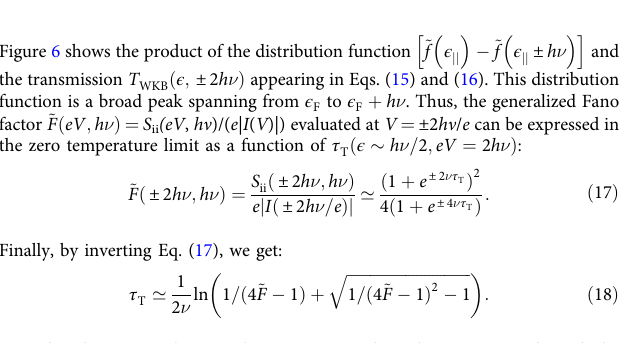
Note that the estimated traversal time corresponds to the 1D motion through the barrier.